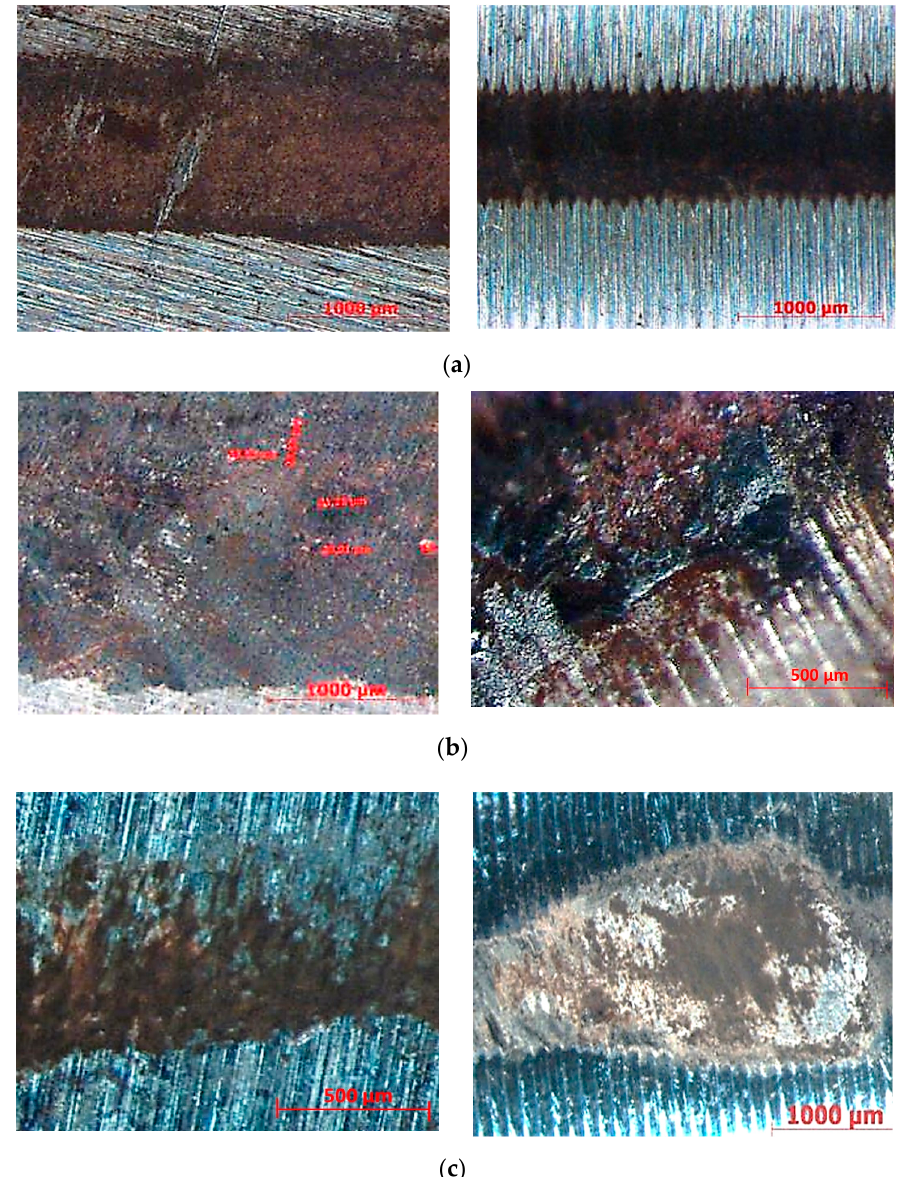
Figure 28. The example of wears of selected samples at tested configuration Cylinder / Plate. ( a ) Samples without surface treatment (only heat-treated): Plate No. 2—30 × magnification (left); Cylinder No. 16, 30 × magnification (right). ( b ) Nitrided samples: Plate No. 14—measurement of layer fragments, 30 × magnification (left); Cylinder No. 17—detail of degradation of nitrided layer, 63 × magnification (right). ( c ) Samples treated by electroless nickel plating: Plate No. 32, 40 × magnification, (left); Cylinder No. 72, 20 × magnification (right).